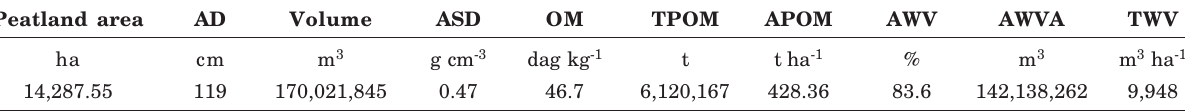
AD.: Average Depth, ASD: Average Soil Density, AOM: Average Organic Matter; TPOM: total pool of organic matter; APOM: average pool of organic matter; AWV: Average Water Volume in the SdEM peatlands (Campos et al., 2012); AWVA: Average Water Volume per Area; TWV: Total Water Volume in the SdEM peatlands.